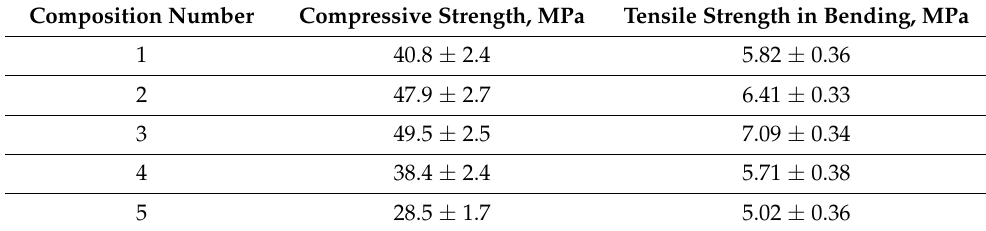
Table 7. The strength properties of cement mixtures.